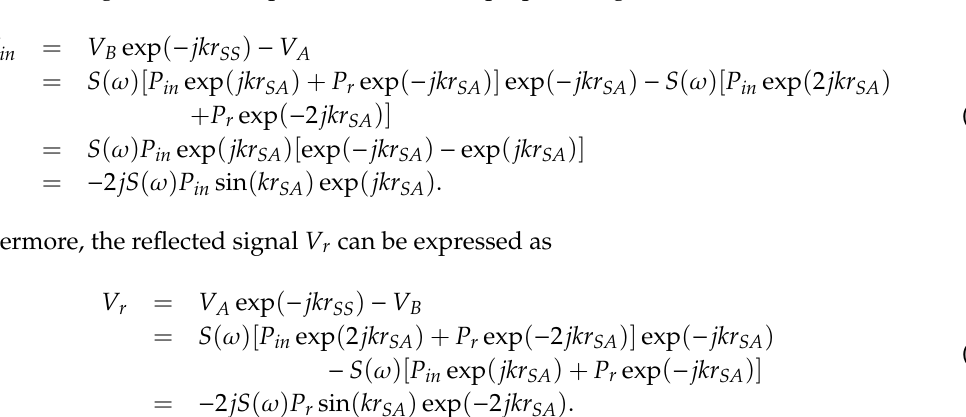
Figure 10. Concept of the multilayer acoustic absorber system.